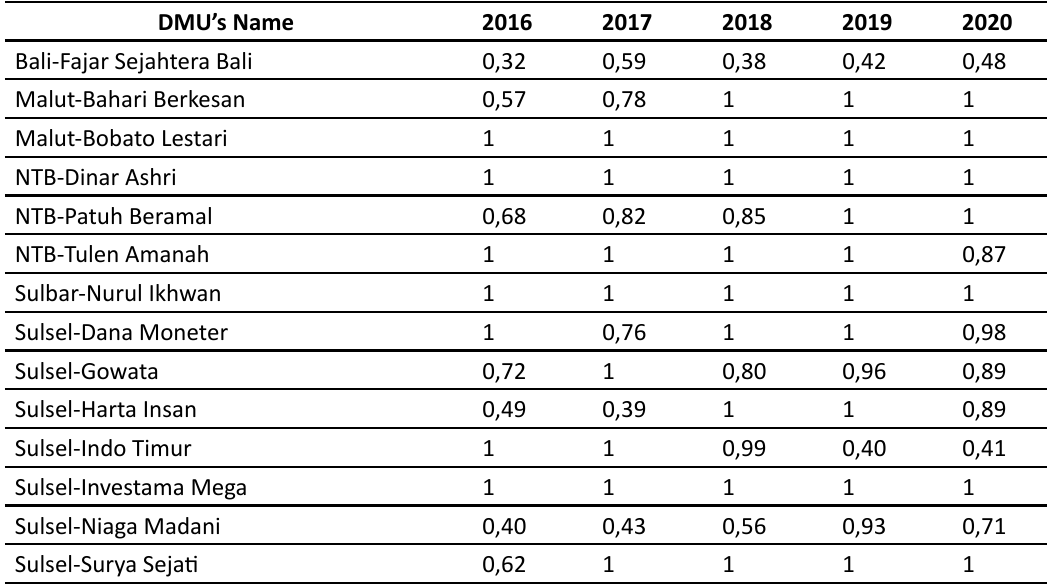
Table 2: BPRS Efficiency Score in Eastern